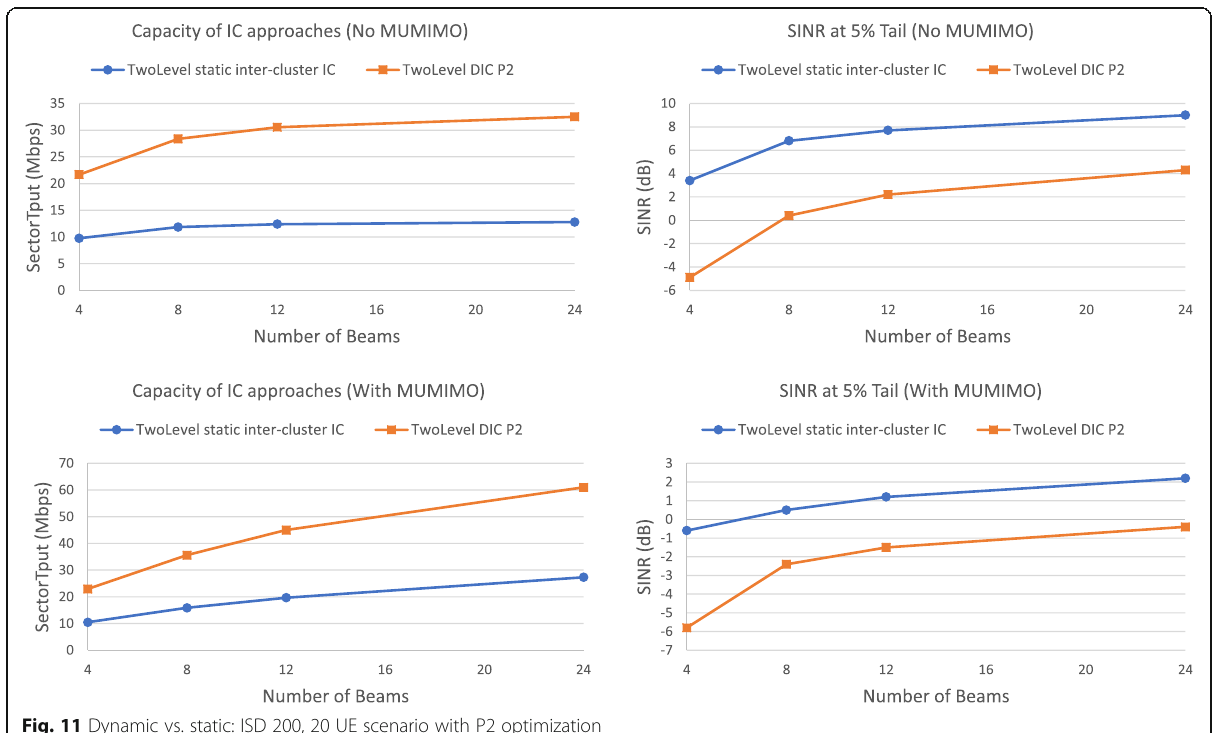
Fig. 11 Dynamic vs. static: ISD 200, 20 UE scenario with P2 optimization